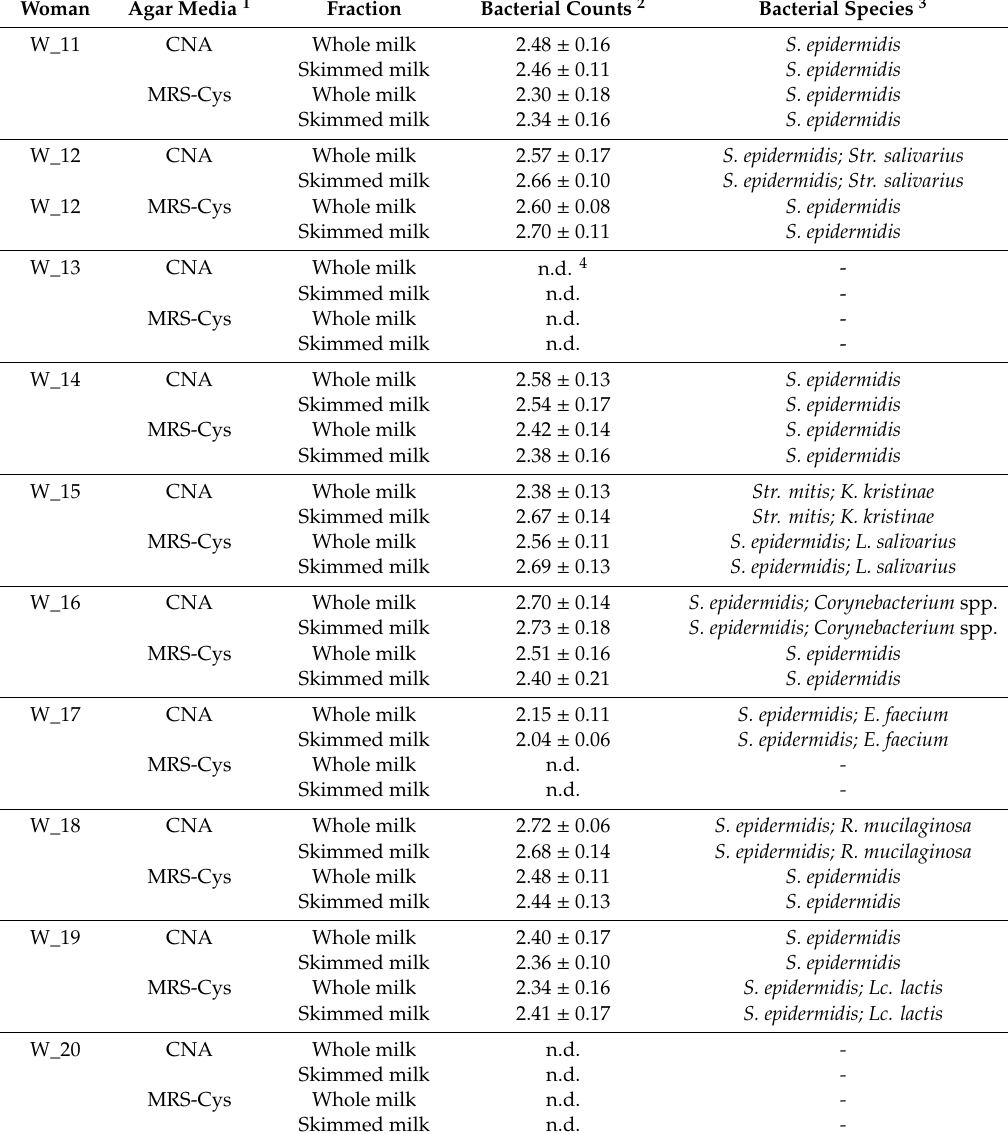
Table 2. Bacterial counts (log 10 cfu / mL) in the aliquots of whole milk and skimmed milk from the samples obtained from women 11 to 20 in this study and identification of the diverse types of colonies observed in the di ff erent agar media where growth was